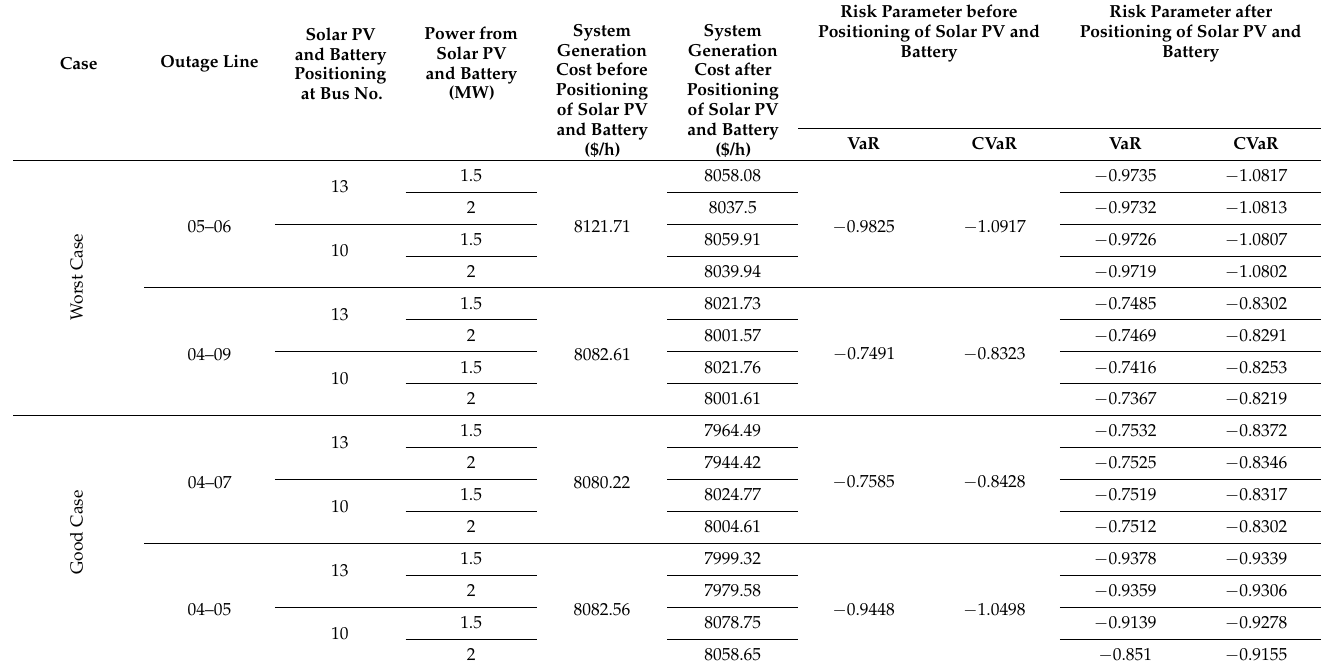
Table 7. VaR and CVaR after Installation of Solar PV and Battery in IEEE 14-bus